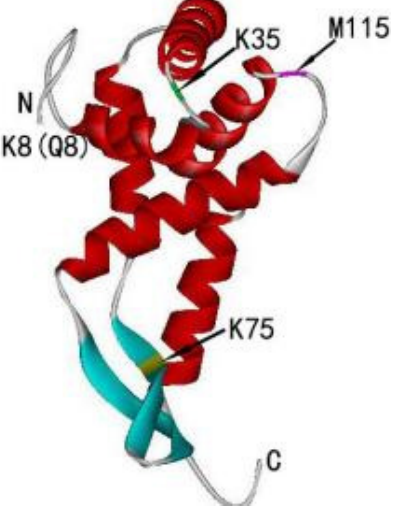
Figure 2. Ribbon representation of the RPS7 protein structure (PDB:1RSS). The red domain is M115, 146 the green domain is K35, and the yellow domain is K75. Regions deleted by mutagenesis are shown in 147 aqua, but residues P1-G11 are absent in this structure.